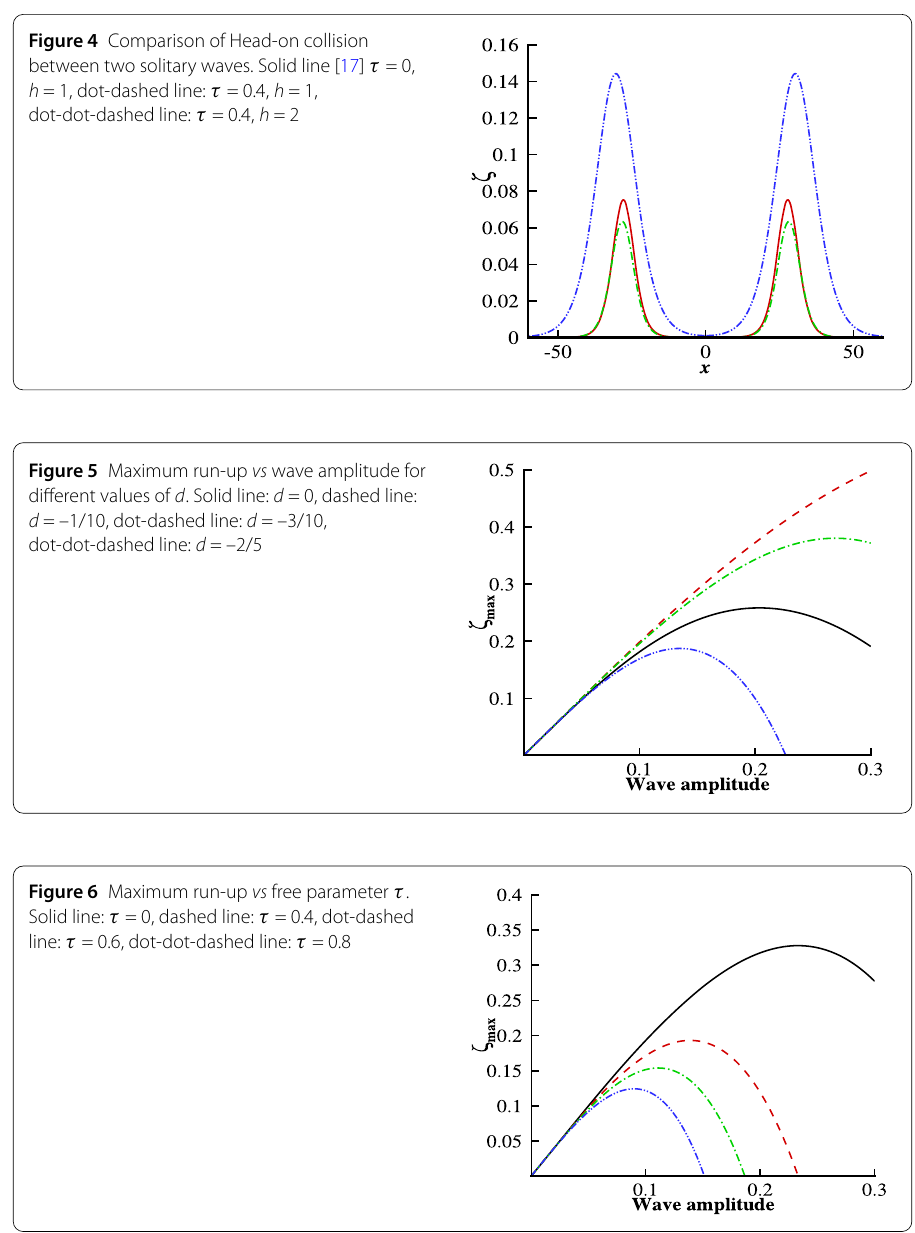
Figure 4 Comparison of Head-on collision between two solitary waves. Solid line [17] τ = 0, h = 1, dot-dashed line: τ = 0.4, h = 1, dot-dot-dashed line: τ = 0.4, h = 2